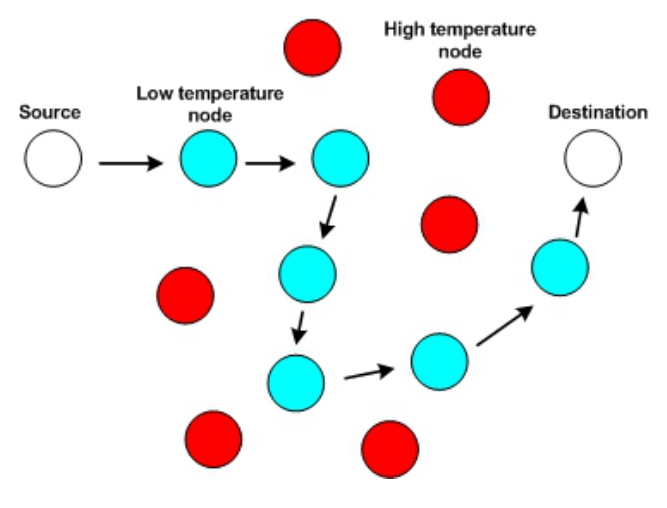
Figure 4. An example of Least Temperature Routing (LTR).